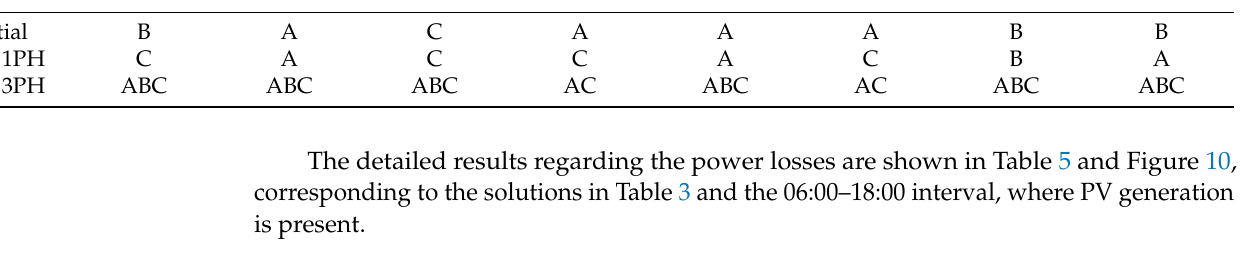
Table 4. Prosumer surplus shifting on the three phases in network R28.